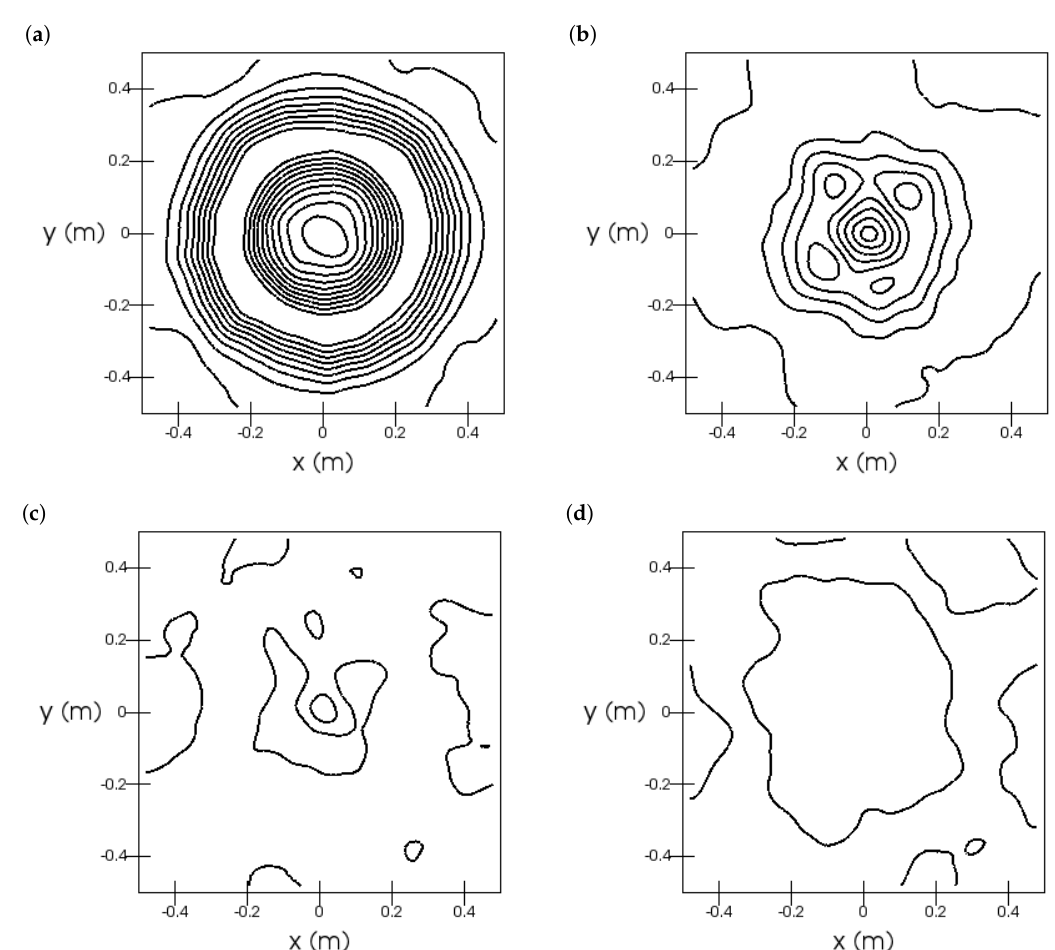
Figure 16. Sandia flame, Test 24: iso-contours of radial velocity. The sub-figures are at heights z = 0.1m ( a ), z = 0.3m ( b ), z = 0.5m ( c ), and z = 0.9m ( d ). The contours are in the range [ − 1, − 0.1 ] ms − 1 with a stride of 0.1ms − 1